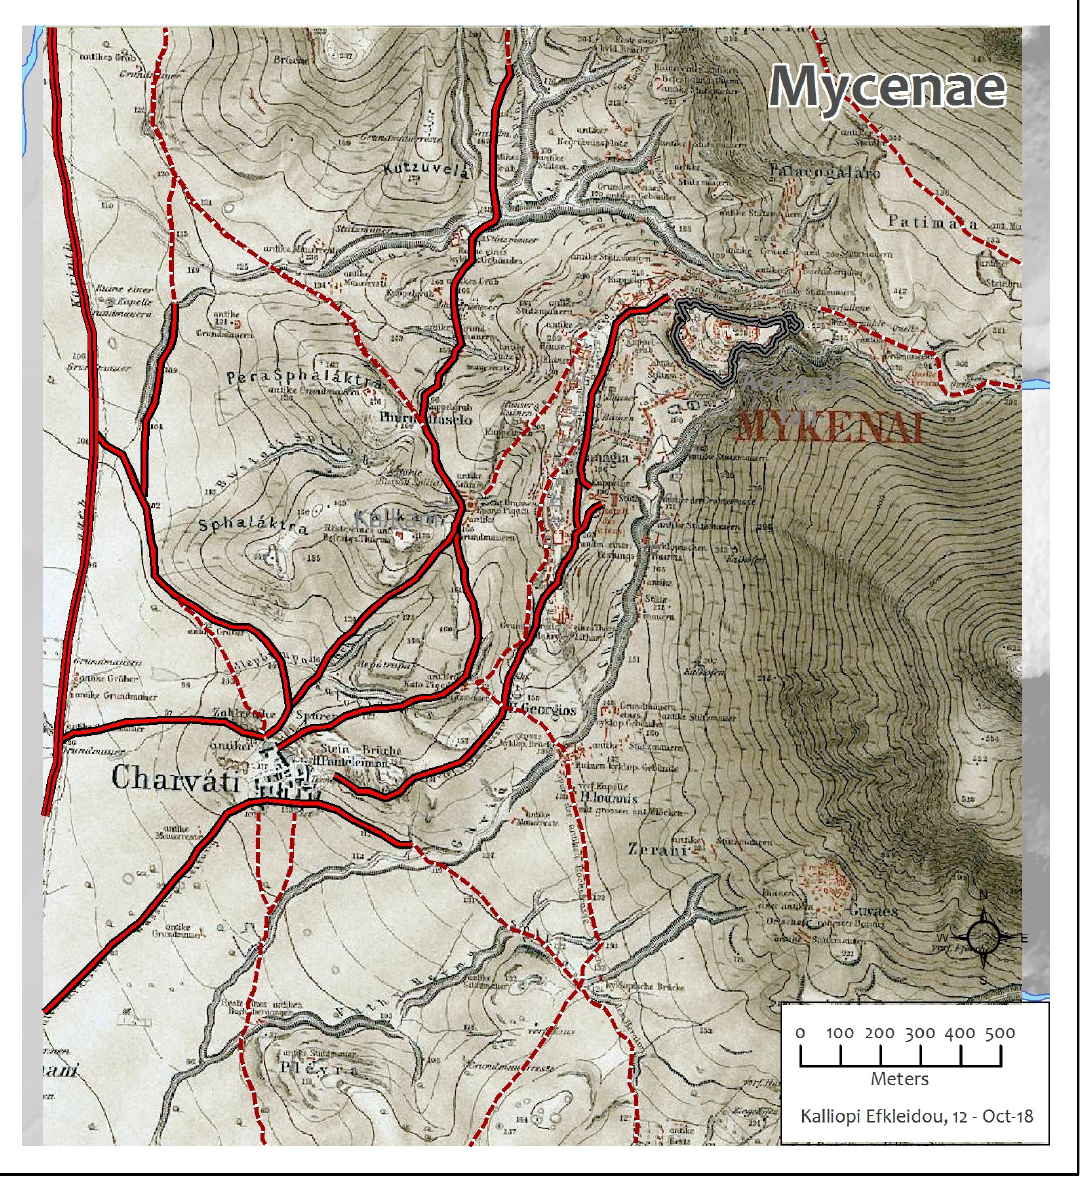
Figure 8. The georeferenced map of Mycenae compiled by Steffen (Steffen, et al., 1884, map 2) and the digitized 19th century road network in the hinterlands of